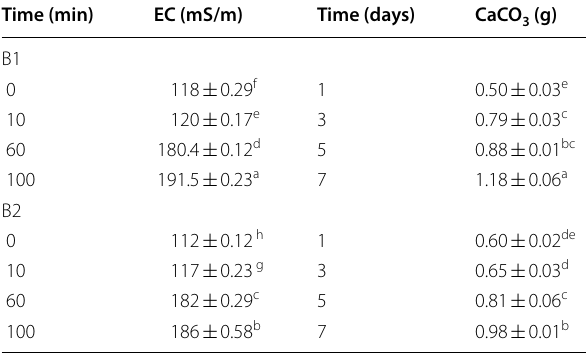
(a, b, …) Average in the same column having different subscripts are differ significantly ( P 0.05) ≤ EC, Electric conductivity; mS/m, millisiemens/meter; B1, Bacillus wiedmannii ; B2: Bacillus